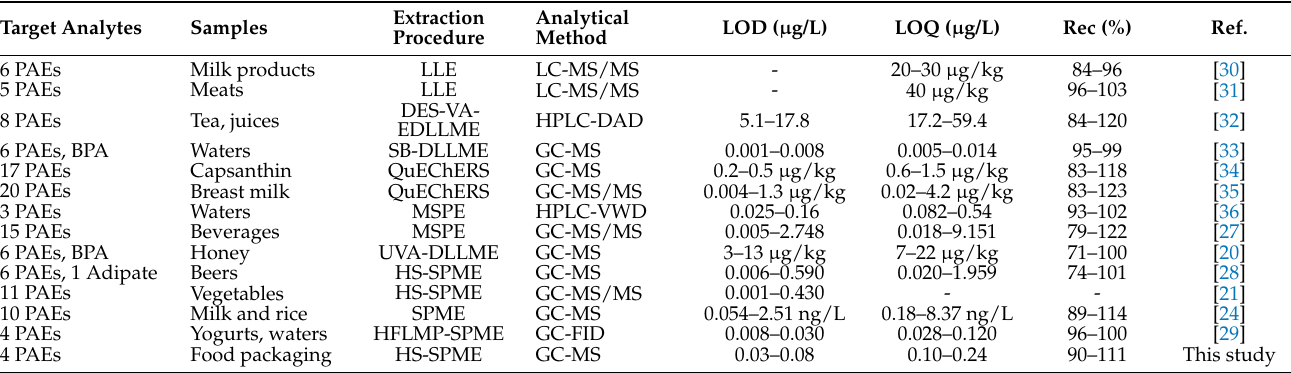
Table 3. Comparison of the analytical performance of the developed method in this study with other studies reported in the